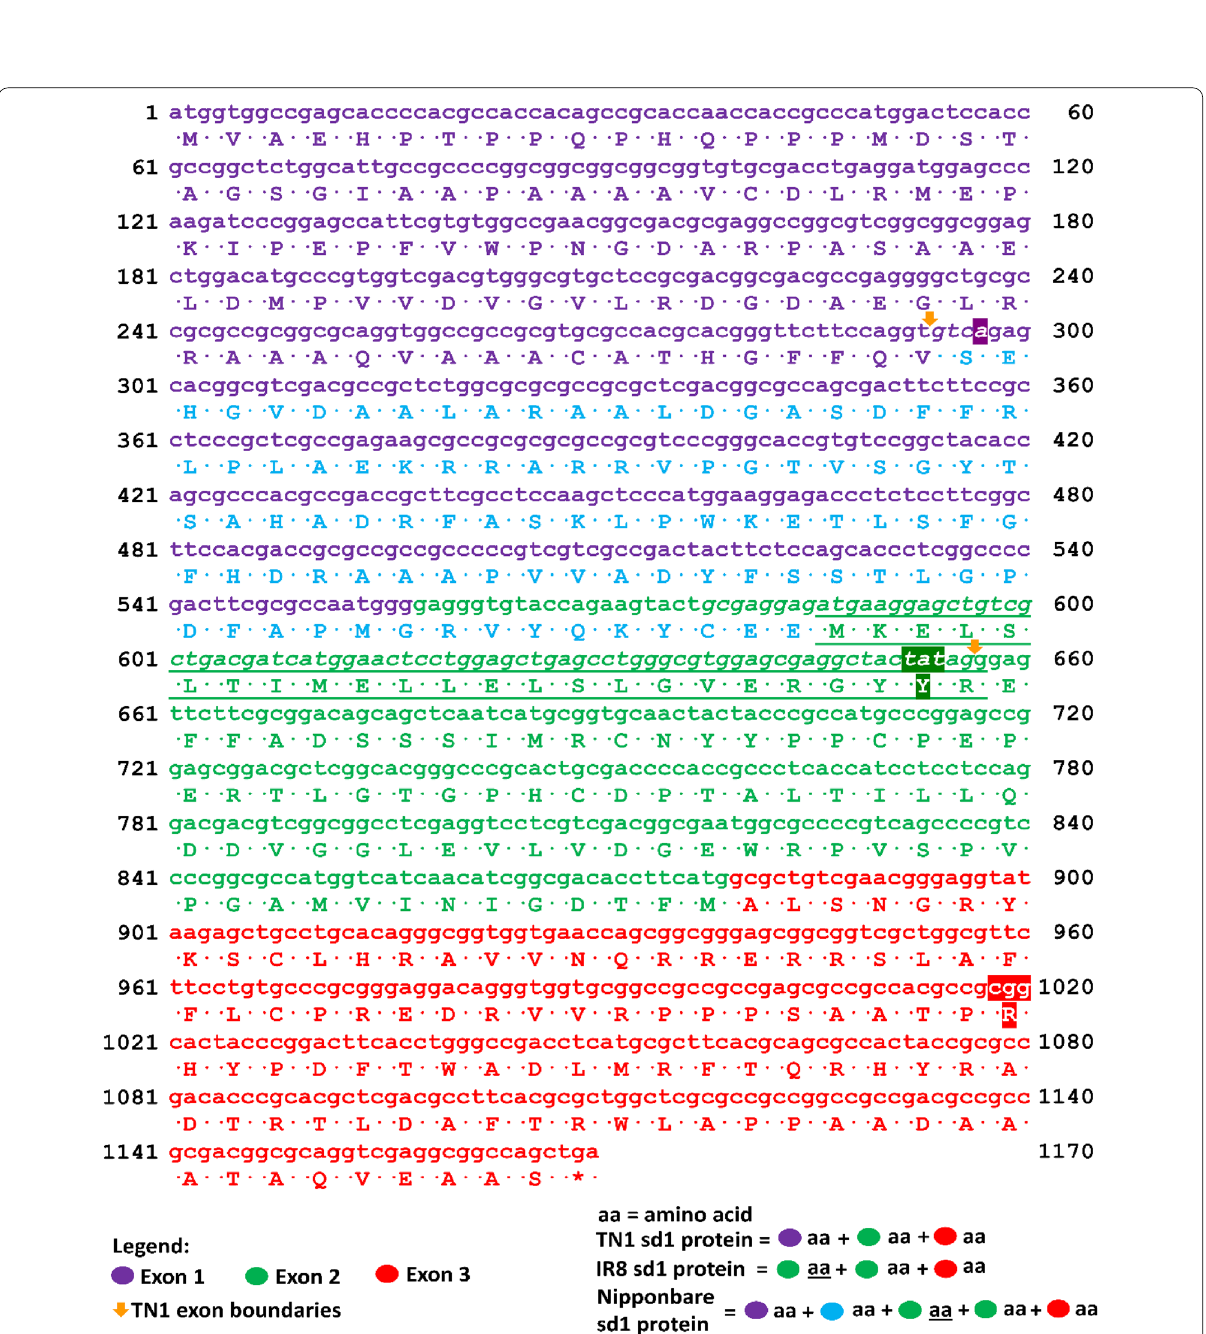
Fig. 5 Predicted coding and amino acid sequences of Nipponbare, TN1 and IR8 sd1 gene sequences. Position 1 is 40,361,934; 39,824,196; and 38,382,466 in chromosome 1 of TN1, IR8 and Nipponbare, respectively. The IR8 sd1 sequence illustrated here is based on its gff annotation dated May 10, 2020 and not yet corrected. TN1 and IR8 CDS and protein sequences were aligned to the Nipponbare CDS via Clustal to see the similarity of the sequences per position. The same Nipponbare CDS was translated and the mapping of its amino acids per codon became the basis of this diagram, such that all nucleotides and amino acid translations were the same for the three cultivars unless indicated. The nucleotides with amino acid translation that are colored light blue and not italicized are the deleted CDS region in TN1 sd1 , which is the exon gap in Fig. 2a. The italicized nucleotides (including the violet shaded adenine) is intron 1 of TN1 sd1 . The colored codon tat (TN1 and IR8) is the synonymous codon of tac of Nipponbare, while codon cgg (TN1 and IR8) is a mutation for codon cag (Nipponbare), which changes amino acid Q (Nipponbare) to R (TN1 and IR8). The violet shaded adenine in codon 1 is the extra nucleotide that caused the 1 bp difference of the genomic deletion of TN1 and IR8 against the sd1 sequence of Monna et al.